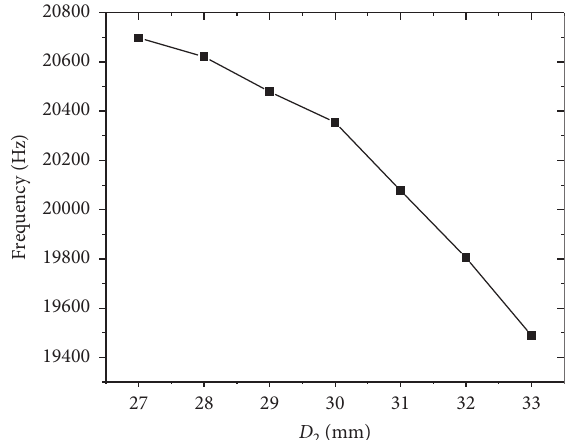
Figure 11: The effect of the inner diameter D part of the compound horn on vibration